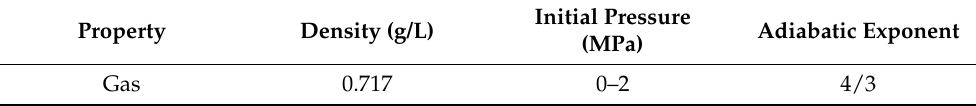
Table 2. Gas expansion mechanical